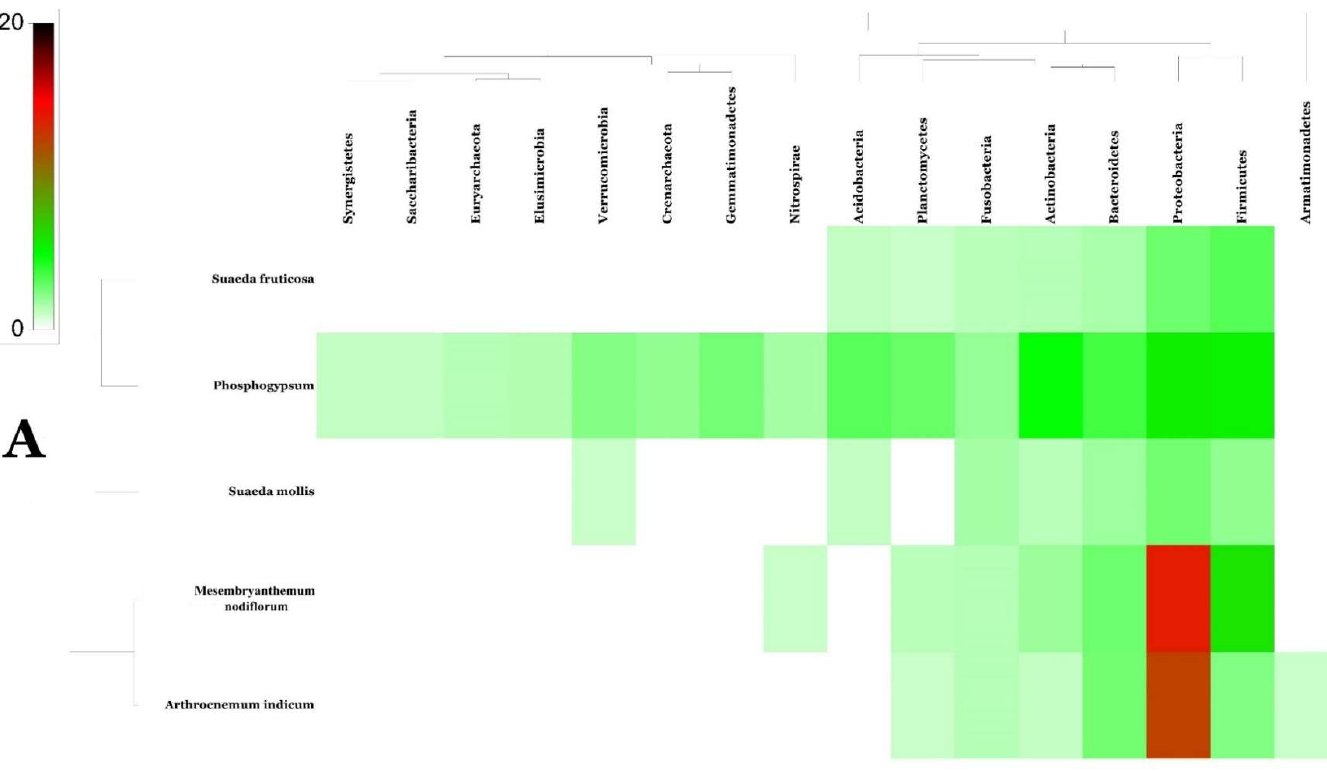
Figure 4. Bacterial community heat map of PG and plant microbiomes generated using SEED2 in phylum ( A ) order ( B ) and class ( C ) levels, respectively. 185